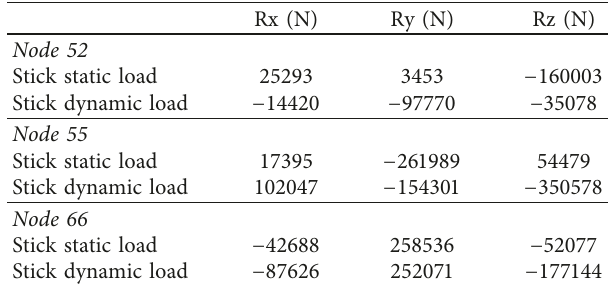
Figure 10: von Mises stresses (MPa) for the trailing arm achieved by (a) 3D full-FE model and (b) Global/local technique. Table 4: Static and dynamic loading conditions (stick